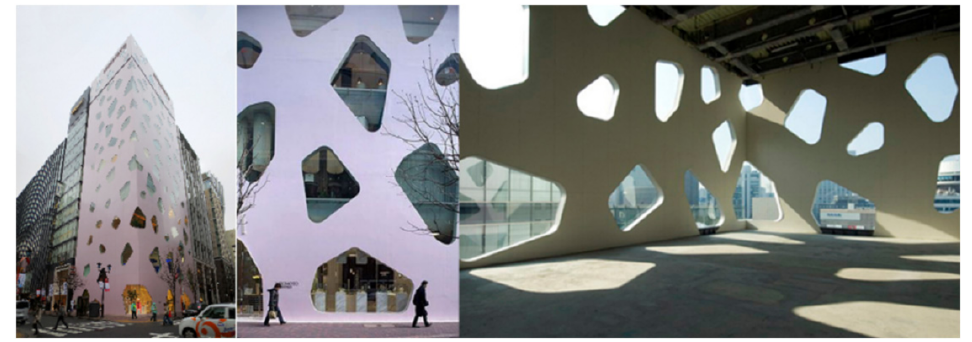
Figure 4. Mikimoto Ginza